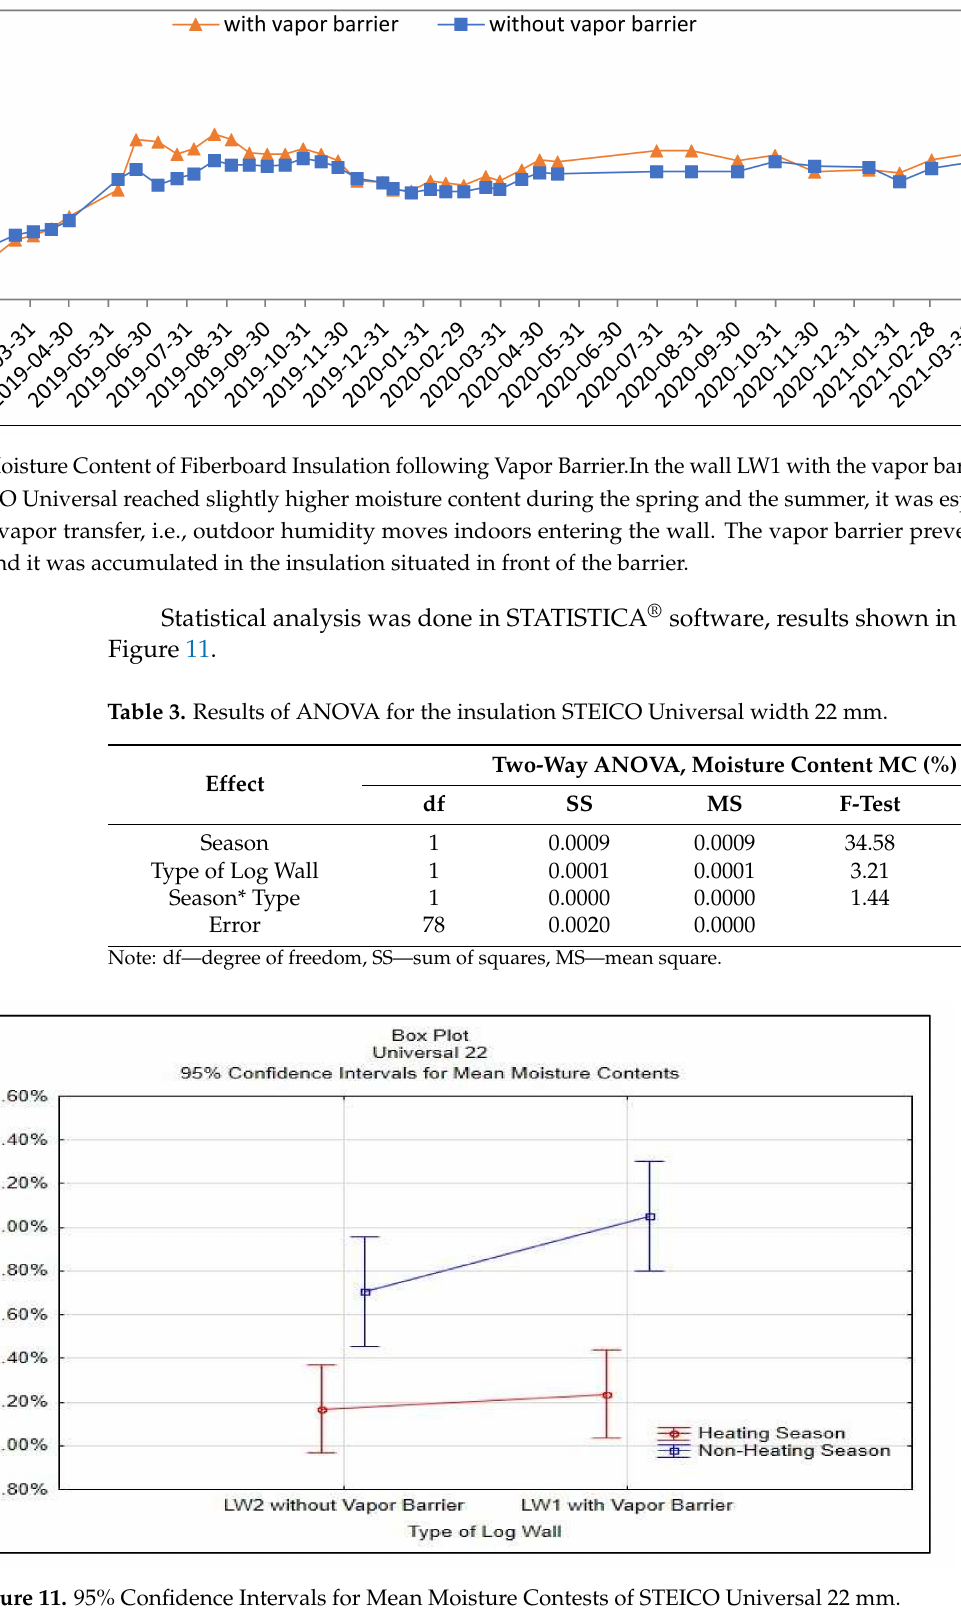
Figure 11. 95% Confidence Intervals for Mean Moisture Contests of STEICO Universal 22